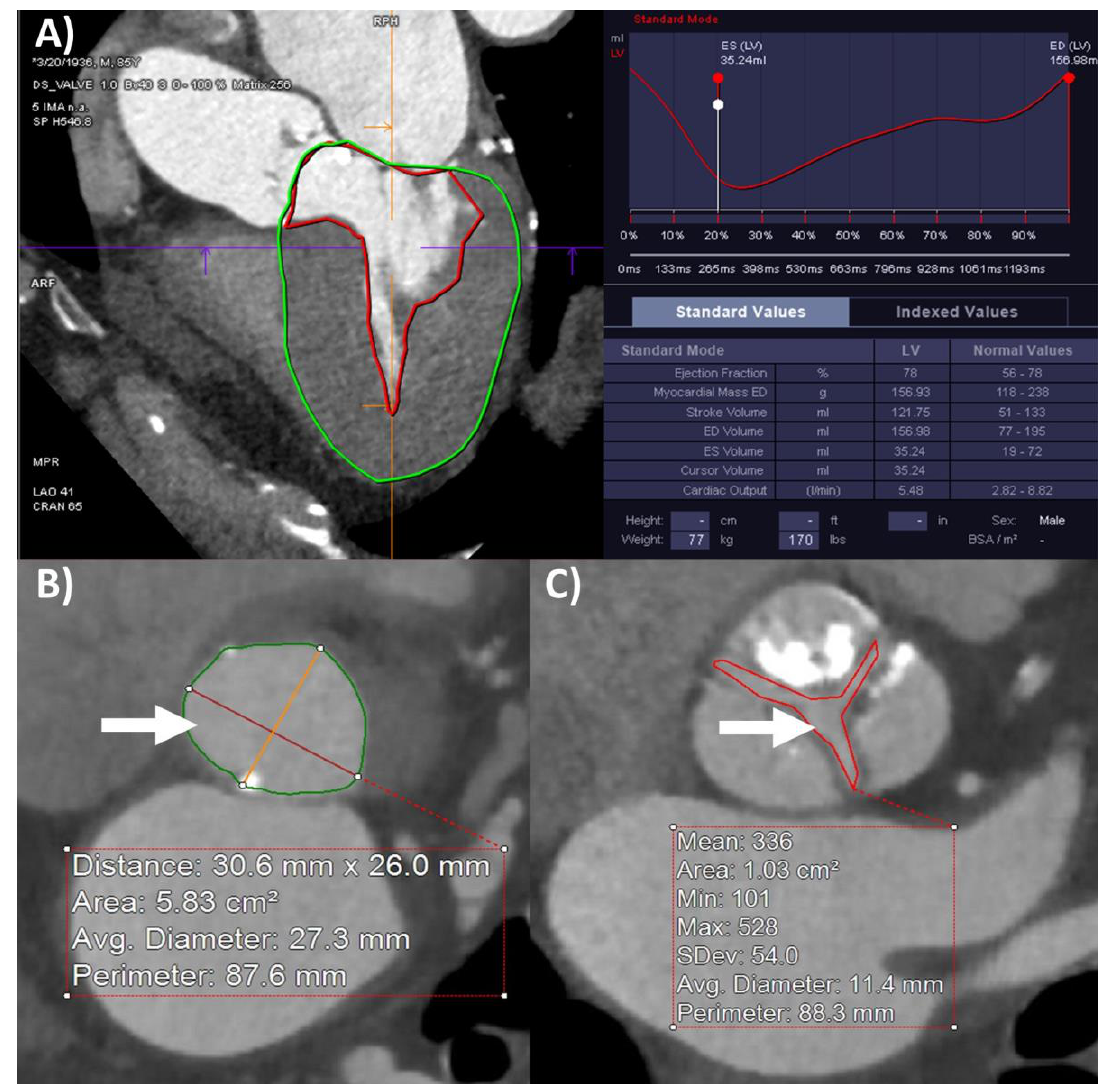
Figure 1. Cardiac computed tomography using four-dimensional retrospective ECG gating and iodinated contrast enhancement for aortic stenosis assessment. ( A ) Left ventricular dimensions end-diastolic (LVEDV), end-systolic (LVESV), and stroke (LVSV) volumes, ejection fraction (LVEF) and mass (LVM) measurements, ( B ) left ventricular outflow tract diameter and area (arrow, measured at 3.1 × 2.6 cm, 5.8 cm 2 ), and ( C ) aortic valve area planimetry (arrow) measured at 1.0 cm 2 .